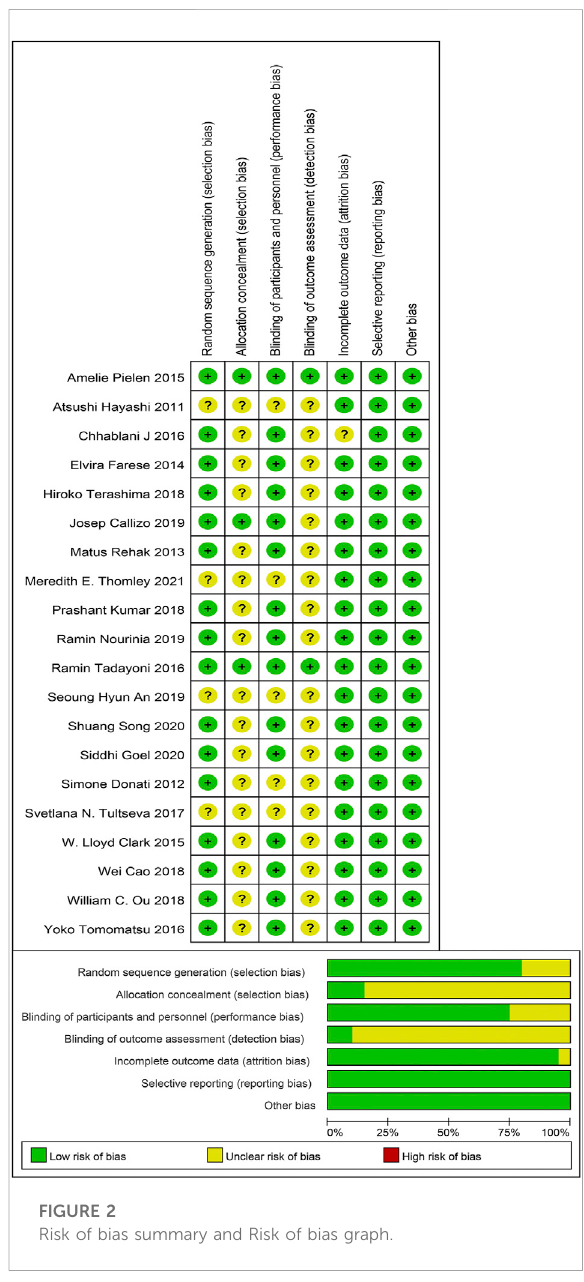
FIGURE 2 Risk of bias summary and Risk of bias